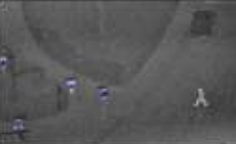
Figure 12. Omitting unnecessary centers in Fig. 11-a.